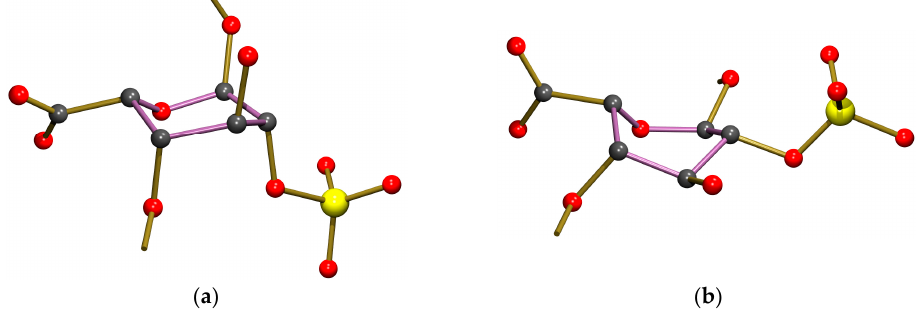
Figure 6. A comparison of the conformations of the iduronic acid G ring structures in uncomplexed Fondaparinux ( a ) and Fondaparinux co-crystallized with antithrombin ( b ; from PDB entry 2GD4) [5]. Fondaparinux ( a ) and Fondaparinux co-crystallized with antithrombin ( b ); from PDB entry 2GD4)